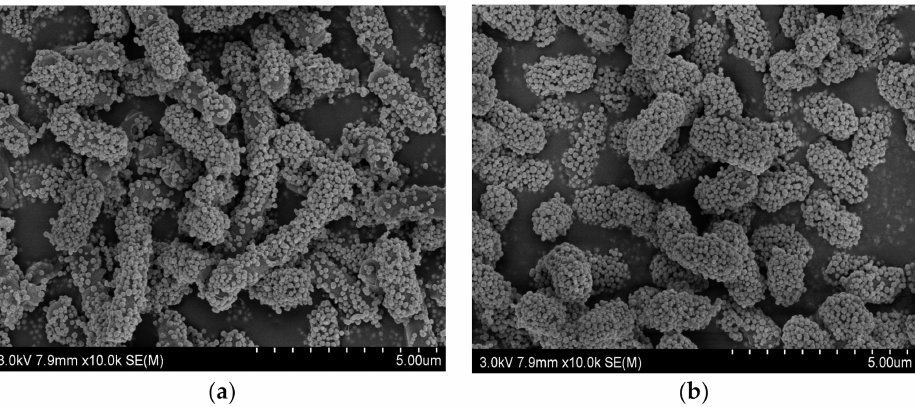
Figure 8. SEM images of ( a ) Fe 3 O 4 @PDA@PEI MBs- Bacillus subtilis conjugates and ( b ) Fe 3 O 4 @ PDA@PEI MBs- E. coli